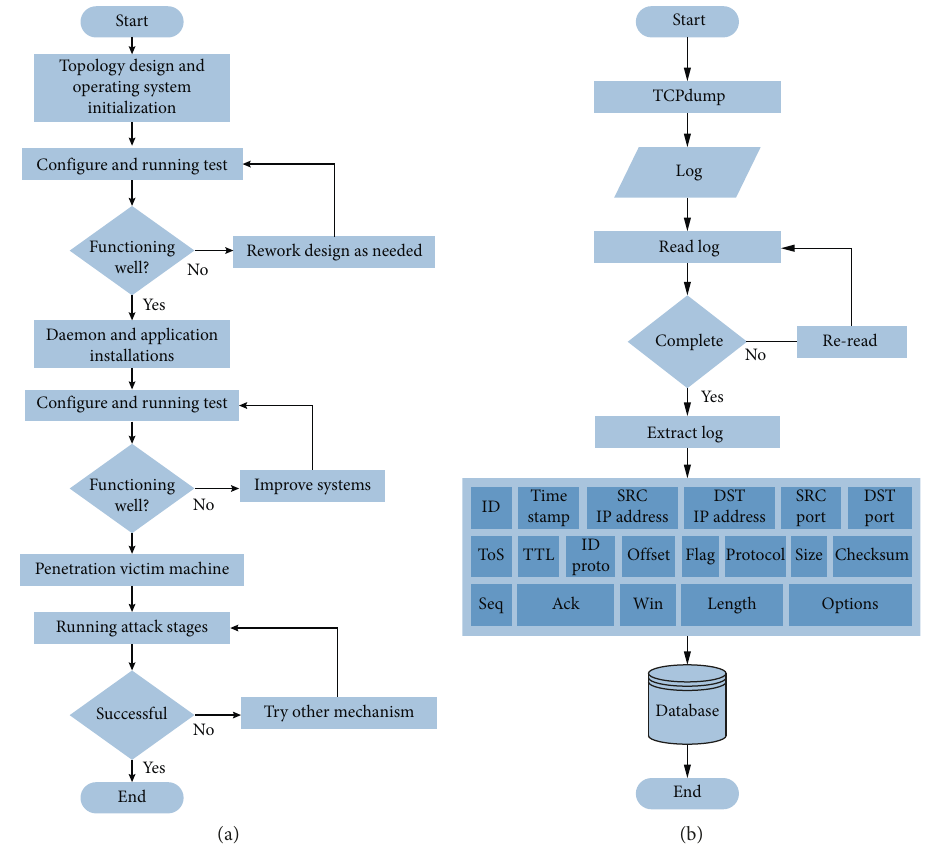
Figure 5: (a) Flowchart of packet capturing preparation; (b) flowchart of packet